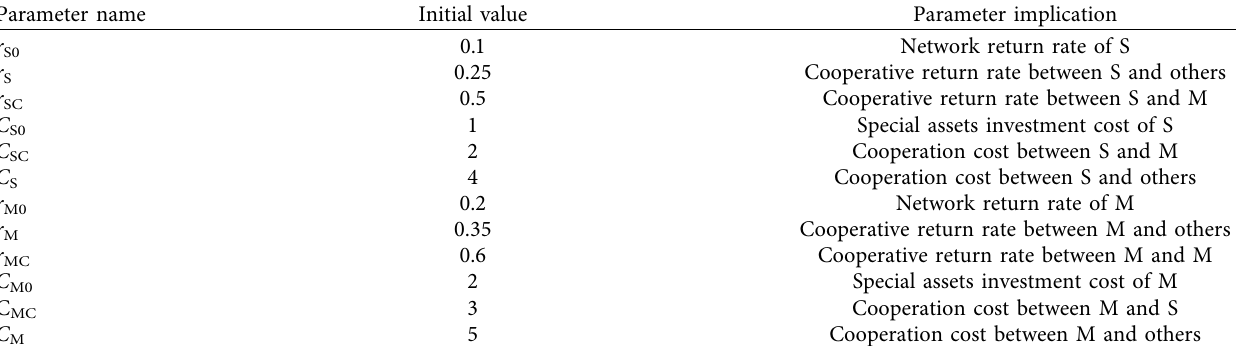
Table 9: Initial values of parameters and implications.